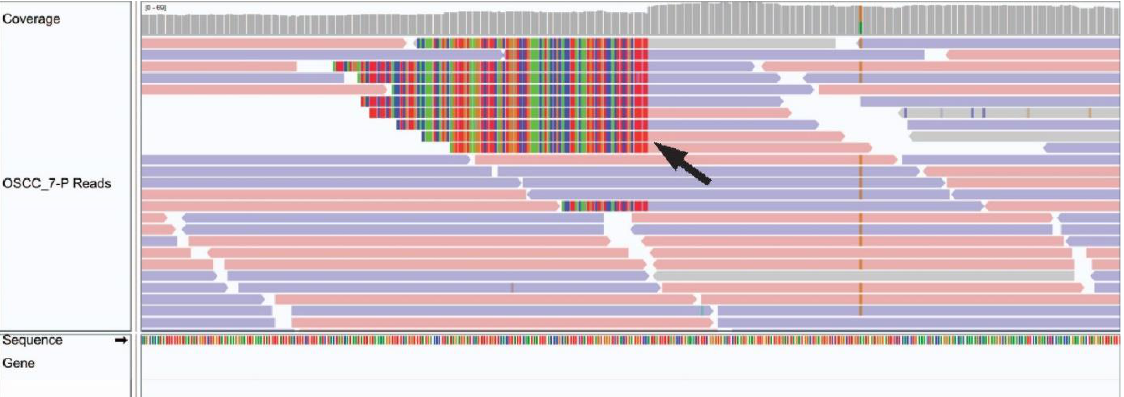
Figure 2. Integrated Genome Viewer image of HPV integration in OSCC tumour genomic sample. A black arrow demonstrates a genomic breakend of an HPV viral insertion.